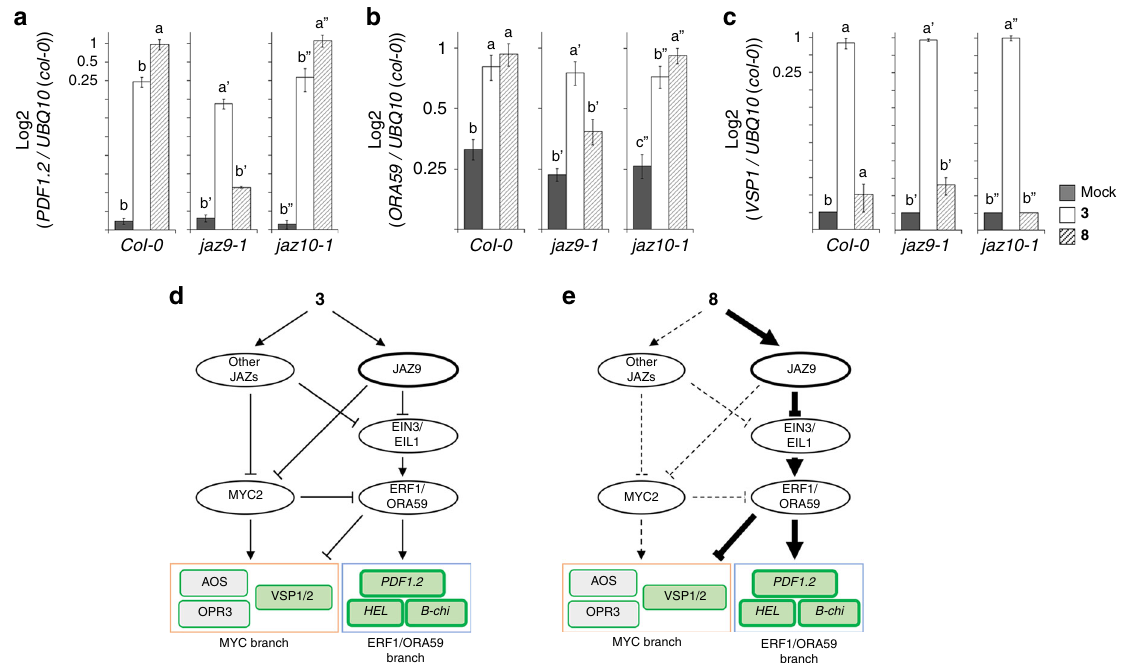
Fig. 6 Selectively activate JAZ9-EIN3/EIL1-ORA59 signaling pathway by 8 . a – c Analysis of JA-responsive gene expression by qRT-PCR in 6-d-old WT (Col- 0), jaz9-1 , or jaz10-1 Arabidopsis seedlings with or without ligands ( 3 or 8 , 1 µ M) treatment ( PDF1.2 ( a ), ORA59 ( b ), or VSP1 ( c )). Results shown are the mean with s.d. ( n = 4). Signi fi cant differences were evaluated by one-way ANOVA/Tukey HSD post hoc test ( p < 0.05). d, e Predicted signaling pathways involving the role of 3 ( d ) or 8 ( e ) for MYC-branch and ERF1/ORA59-branch gene